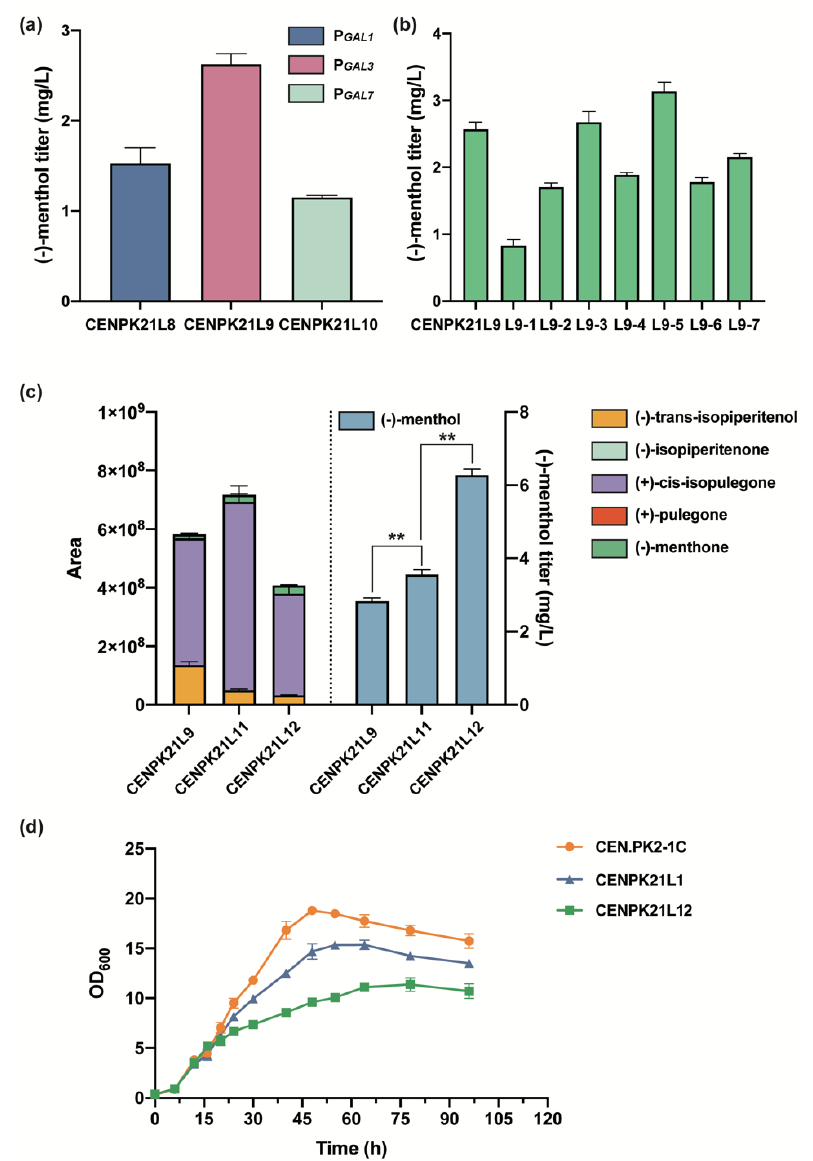
Figure 4. Optimization of the downstream pathway for ( − )-menthol synthesis: ( a ) effect of different promoters of MMR on ( − )-menthol titer; ( b ) effect of the enhanced expression of menthol downstream pathway genes by plasmids on ( − )-menthol titer; ( c ) accumulation of different intermediates and corresponding ( − )-menthol titers in menthol synthesis (Statistical significance is indicated as ** for p < 0.01); and ( d ) comparison of the OD 600 of different strains.